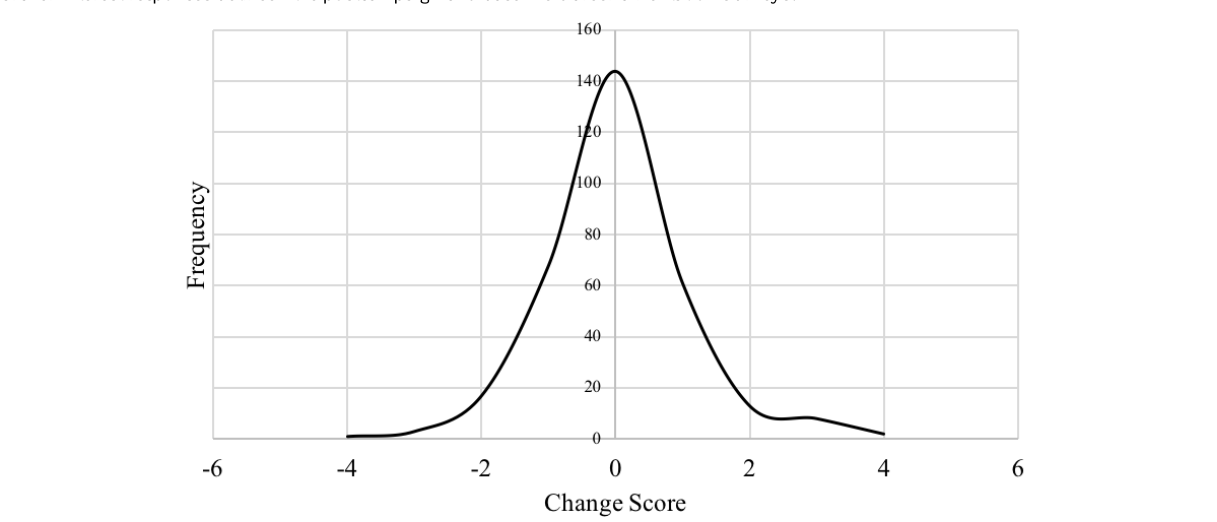
Figure 2. Change in career interest over time (2014-2017). Career interest was assessed using the Likert-type question, “how interested are you in pursuing a career in clinical research?” with responses ranging from “definitely not interested” to “definitely interested.” Positive interest was indicated by a response of “definitely interested” or “very interested.” The change score variable was calculated by taking the difference of Likert scores for researcher interest responses between the postcampaign and baseline Career Orientation